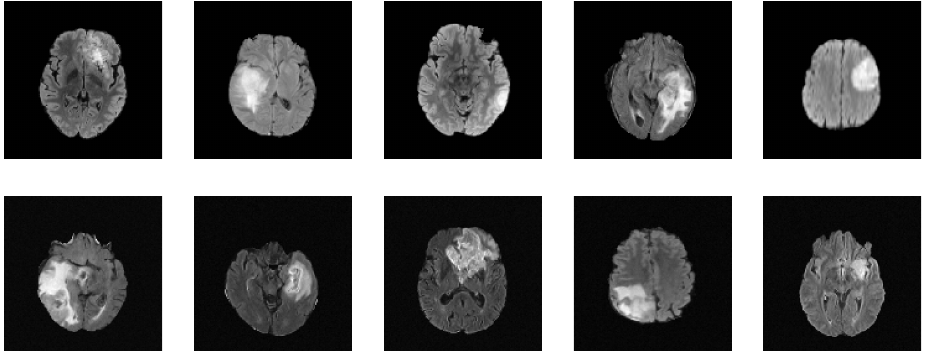
Figure 4. Synthesized MRIs using a diffusion-based probabilistic model (DDPM) [20] trained on the BraTS2020 dataset. The first row shows a sample of original images, while the second row shows a sample of synthesized images generated using the